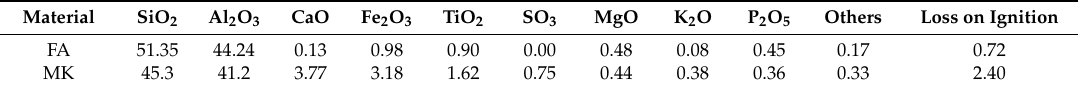
Table 1. Chemical composition (wt%) of fly ash and